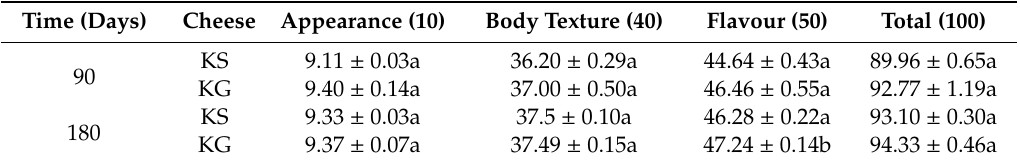
Table 3. Changes of organoleptic characteristics of mature kashkaval of Pindos cheese made from 100% sheep (KS) or a mixture of 90% sheep milk–10% goat (KG) milk during storage.